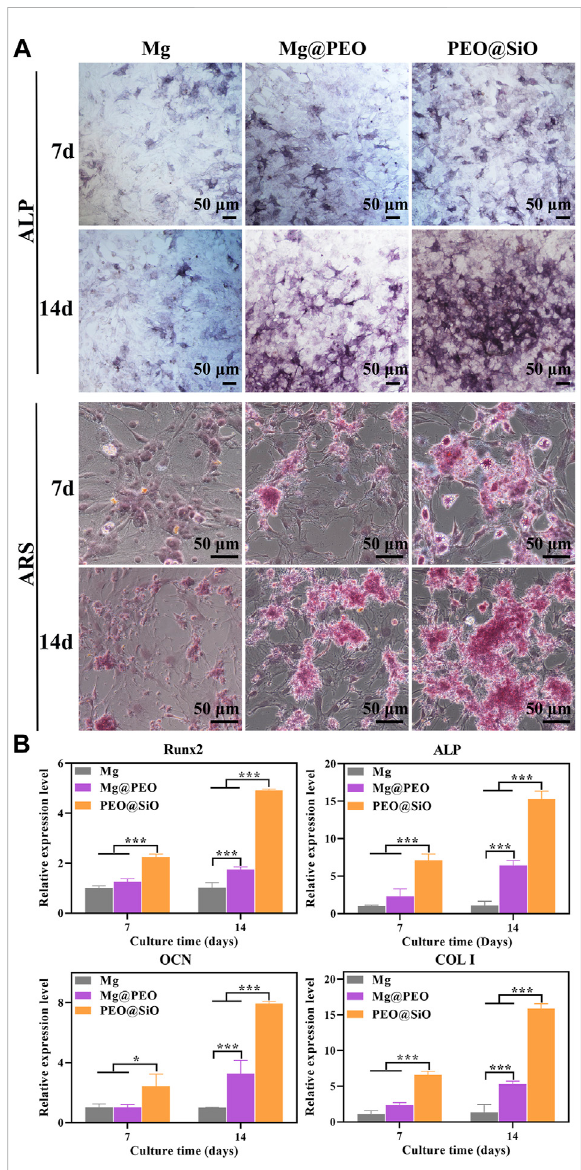
FIGURE 5 In vitro evaluation of osteogenesis: (A) Osteogenic differentiation was evaluated using ALP staining, and extracellular matrix mineralization was evaluated using Alizarin Red staining of MC3T3-E1 cultured on various samples for 7 and 14 days, respectively. (B) Relative mRNA expression of osteogenesis- relatedgenesincludingRunx2,ALP,OCN,andCOLIforMC3T3-E1 culturedonvarioussamplesfor7and14 days;* p < 0.05and*** p <